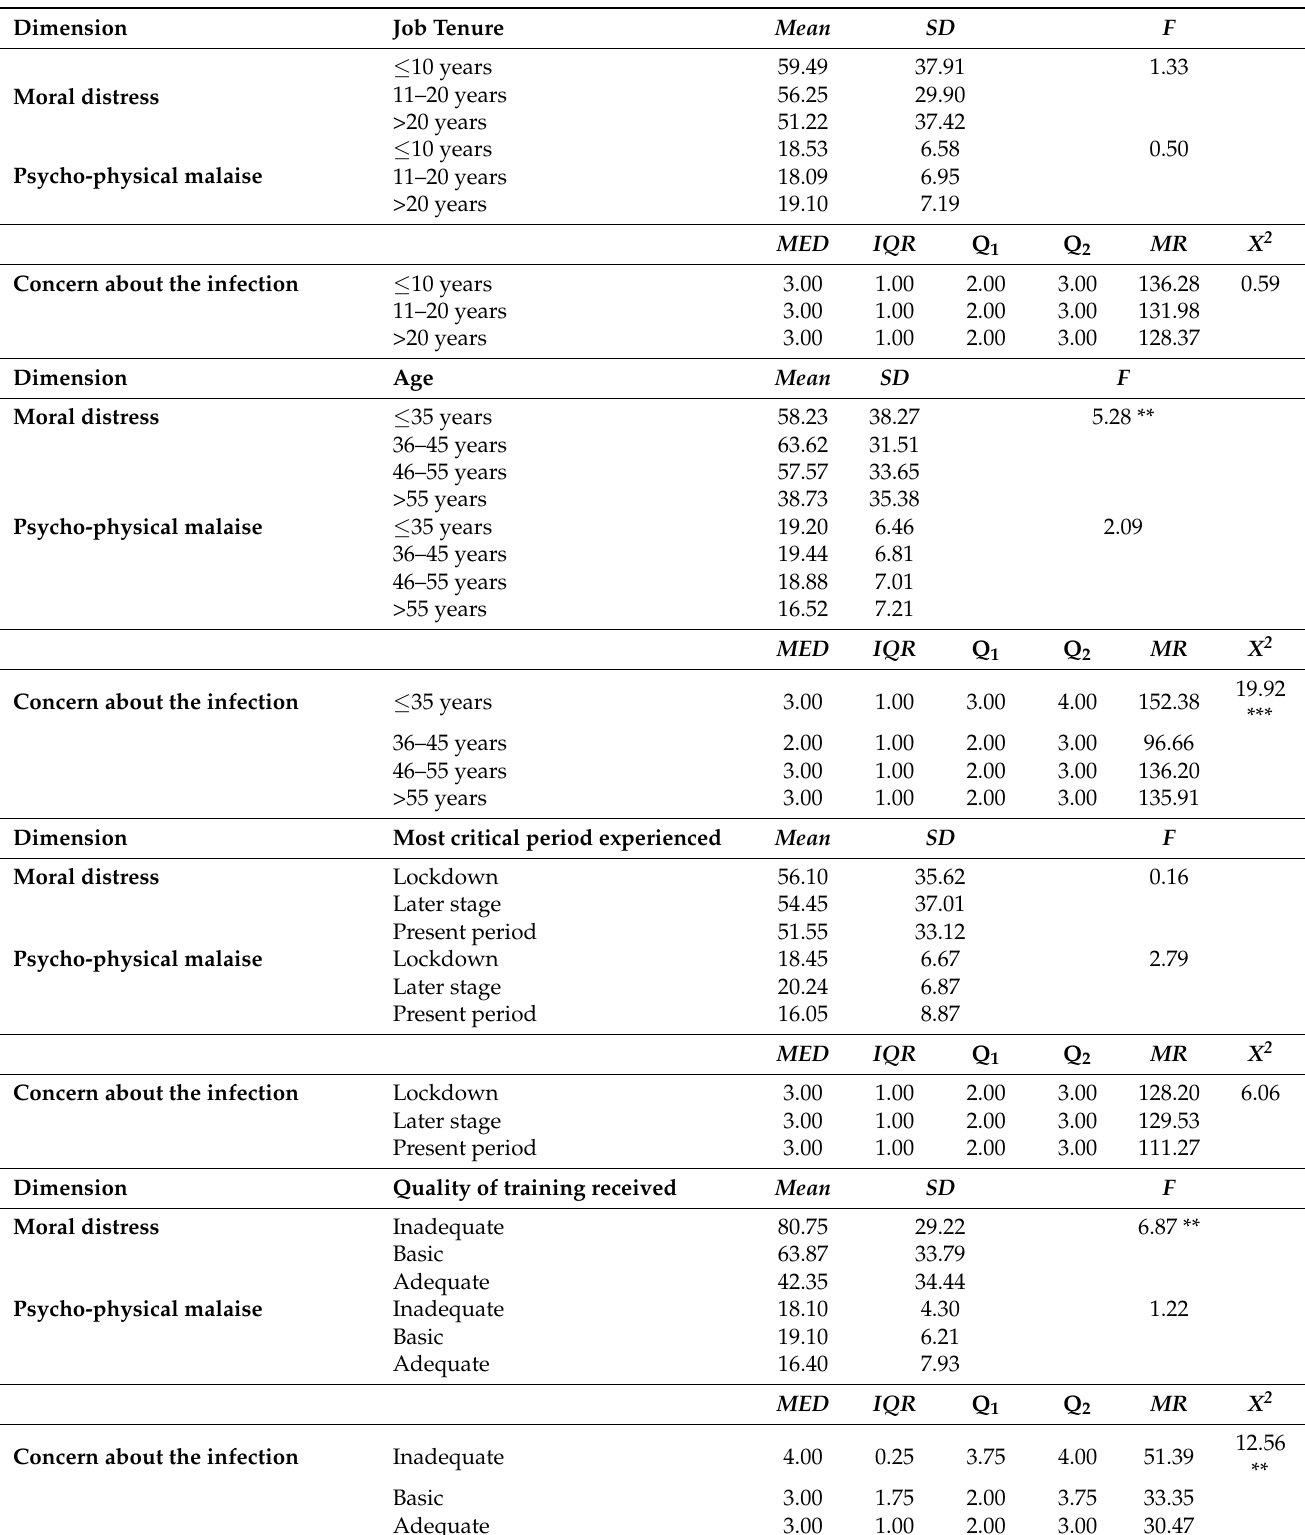
Table 6. ANOVAs and Kruskal-Wallis H tests between age, years of experience, quality of training, most critical period experienced groups regarding the study’s